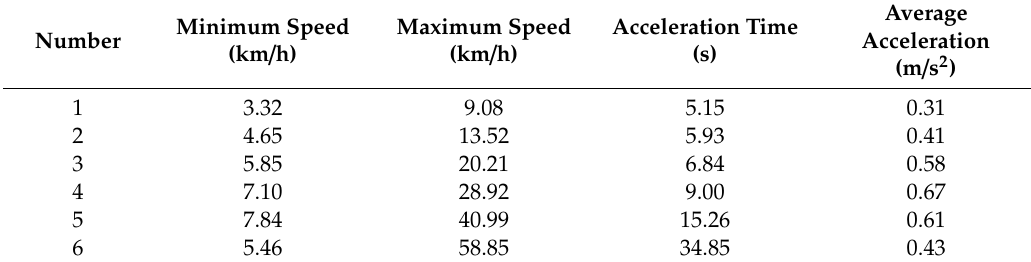
Table 2. Acceleration